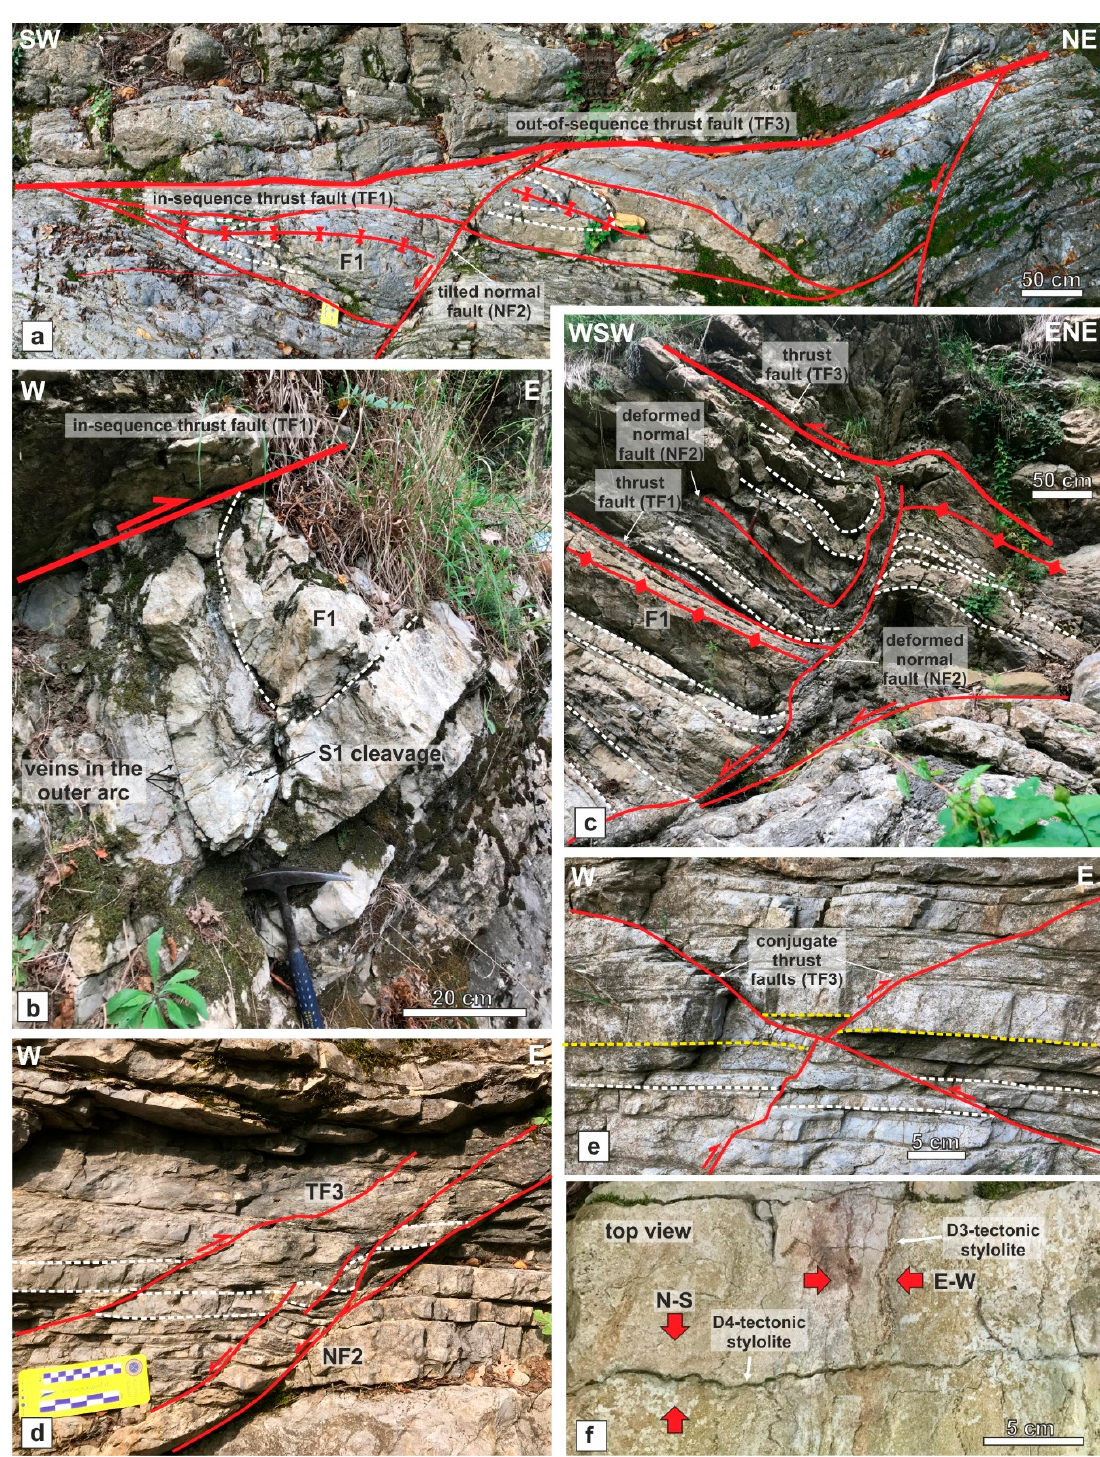
Figure 5. Campagna tectonic window (Salitto). Mt Croce unit: ( a ) early fold and thrusts (TF1) crosscut by normal faults (NF2) subsequently cut by a late thrust (TF3); ( b ) early thrust fault (TF1) verging to the east with an associated overturned syncline in the footwall, the fold host veins in the outer arc, and cleavage in the inner arc; ( c ) early normal faults (NF2) subsequently deformed by a late thrust fault (TF3); ( d ) normal (NF2) and thrust (TF3) faults; ( e ) conjugate thrust faults; ( f ) two orthogonal sets of stylolites.